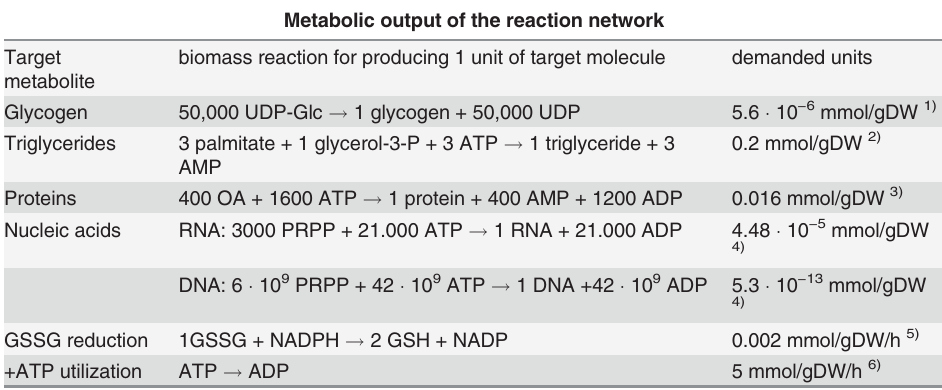
Table 1. Demand of output metabolites and associated energy